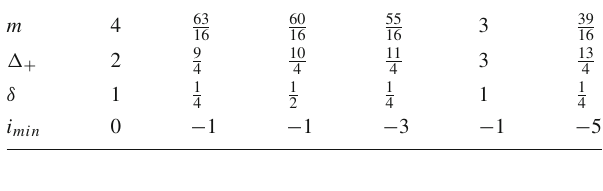
Table 1 The numerical values for series expansion near the